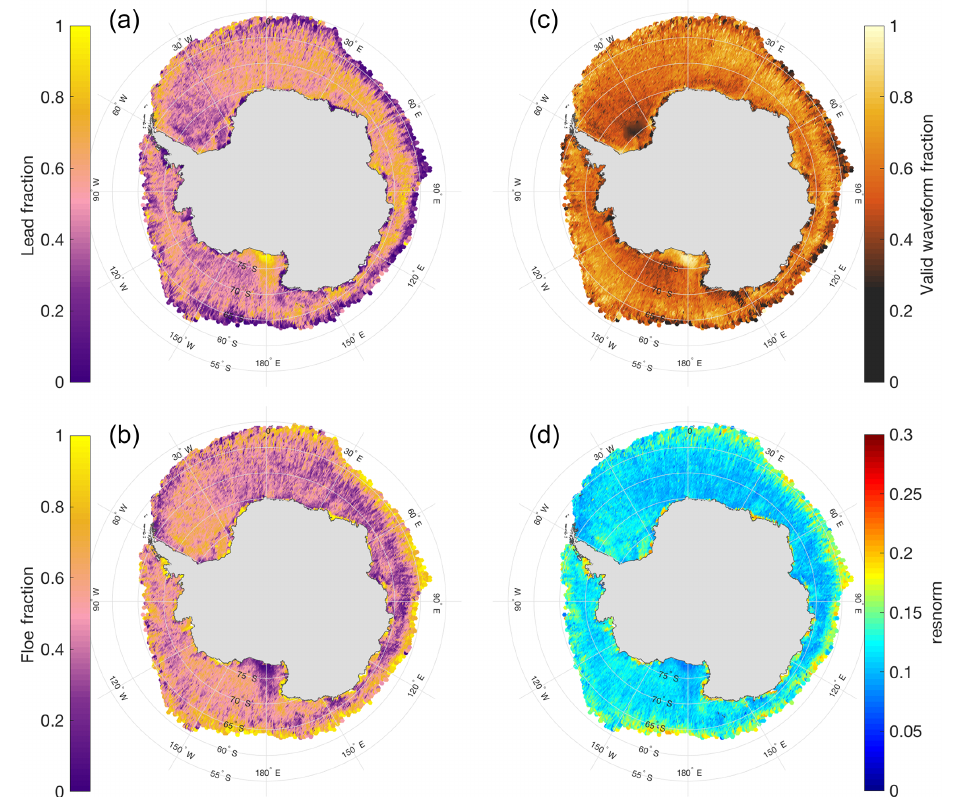
Figure 5. October 2011–2017 average maps of lead-type waveform fraction (a) , floe-type waveform fraction (b) , valid waveform fraction (c) , and resnorm value (d)